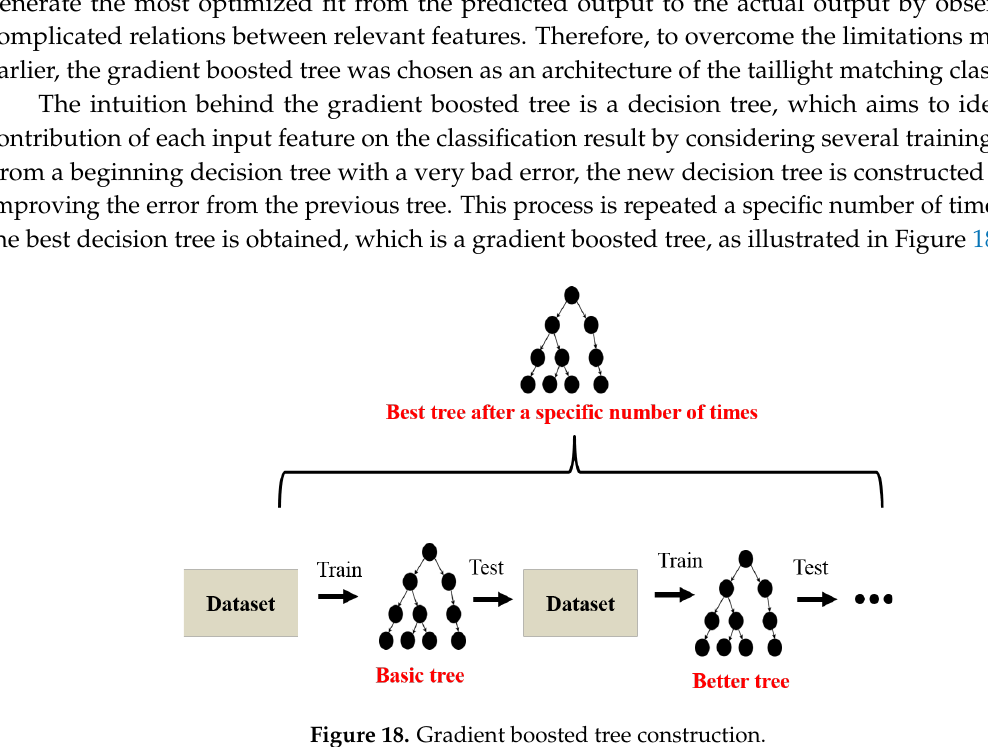
Figure 18. Gradient boosted tree construction.